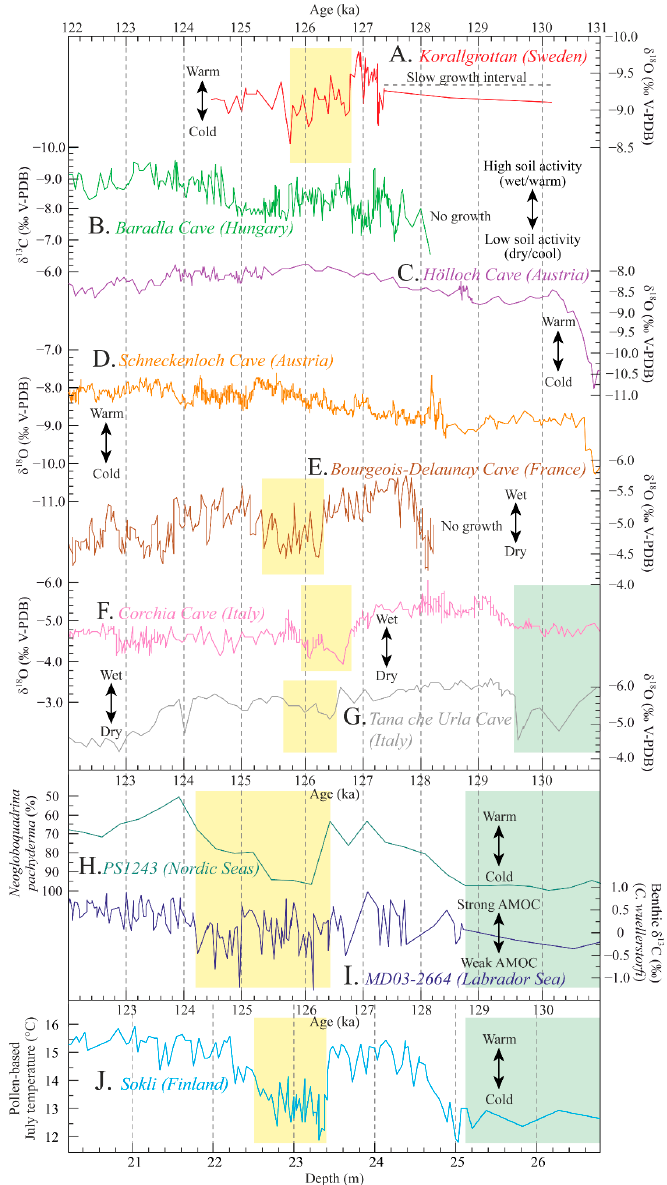
Figure 5. Comparison between δ 18 O in Kf-21 and other speleothem records from other parts of Europe arranged from north to south (upper part) and between δ 18 O in Kf-21 and reconstructed summer temperatures from Sokli (northeast Finland) and sites in the North Atlantic (lower part). A: Korallgrottan, Kf-21, this study; B: Baradla Cave, δ 13 C from stalagmite BAR-II #B [31]; C: Hölloch, δ 18 O from stalagmite HÖL-10 [32]; D: Schneckenloch, δ 18 O from stalagmite SCH-5 [32]; E: Bourgeois-Delaunay Cave, δ 18 O in stalagmite BD-inf [33]; F: Corchia Cave, stacked δ 18 O [36]; G: Tana che Urla, δ 18 O from stalagmite D4 [37]; H and I: North Atlantic sites PS1243 [27,28] and MD03-2664 [30]; J: Sokli T jul [22]. For location of sites, see Figure 1. Yellow bars indicate the cold period in Korallgrottan between ~126.77 and ~125.68 ka that is nearly coeval with drier conditions in three other caves sites and evidence for weak Atlantic meridional overturning circulation (AMOC) and low temperatures in the North Atlantic as well as in Sokli (northeast Finland). Green bar indicates early LIG cold